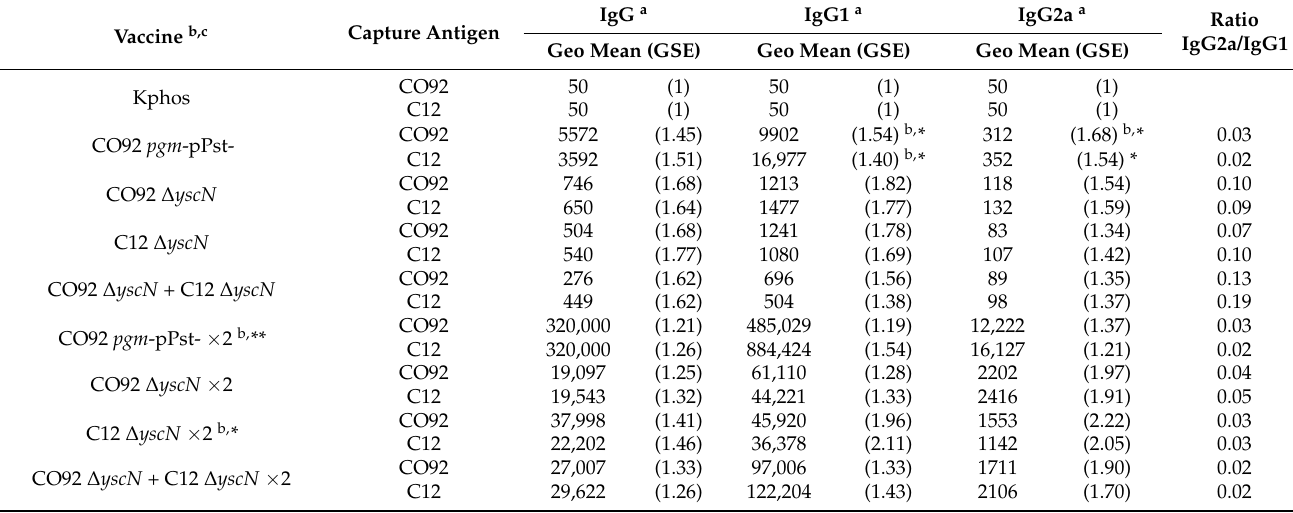
a 30 ◦ C antigens. Antibody titers are shown as the geometric mean (Geo Mean) with geometric standard error (GSE). b n = 10 for each group of mice, except * n = 9. ** n = 5; mice used for immunological analyses (not challenged with virulent plague) and these mice received the booster vaccine 28 days after the primary vaccination. c Single SC vaccination. Double SC vaccination if notated ×